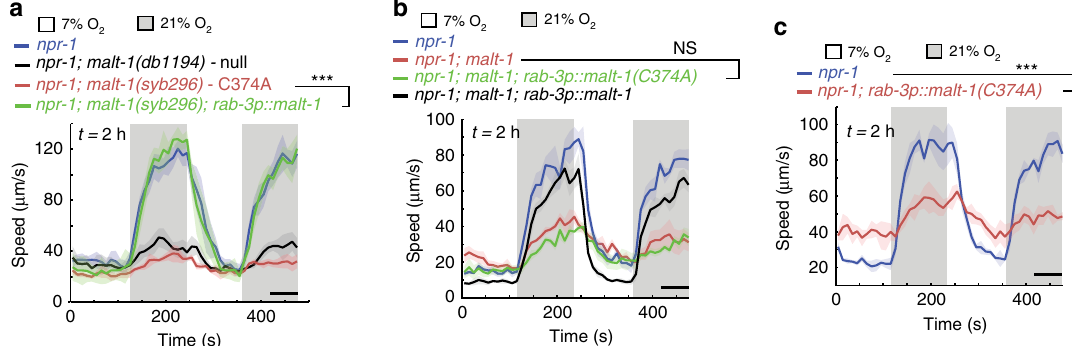
Fig. 5 MALT-1 has enzymatic roles in IL-17 signaling. a – c MALT-1 ’ s function in the nervous system requires its protease active site. a malt-1(syb296) mutants that express a catalytically inactive MALT-1 (C374A) show O 2 response defects comparable to those of malt-1(null) animals. Pan-neuronal expression of malt-1 cDNA rescues this phenotype. n = 53 animals ( npr-1 ), n = 55 animals ( npr-1; malt-1(db1194) ), n = 50 animals ( npr-1; malt-1(syb296) ), n = 29 animals ( npr-1; malt-1(syb296); rab-3p::malt-1 ). Plots show average speed (line) and SEM (shaded regions). *** P = 2.95e − 09, two-sided Mann- Whitney U test. b cDNA encoding a MALT-1 C374A catalytically inactive protein, expressed from the rab-3 promoter, does not rescue the O 2 response defects of malt-1 mutants. Data corresponding to npr-1 and npr-1; malt-1; rab-3p::malt-1 in b are the same as those shown in Fig. 1m, and were obtained in parallel to the genotypes shown. n = 46 animals ( npr-1 ), n = 74 animals ( npr-1; malt-1 ), n = 71 animals ( npr-1; malt-1; rab-3p::malt-1(C374A) ), n = 46 animals ( npr-1; malt-1; rab-3p::malt-1 ). Plots show average speed (line) and SEM (shaded regions). NS, P = 0.693918, two-sided Mann-Whitney U test. c Overexpressing MALT-1 C374A cDNA in npr-1 animals inhibits the arousal response to 21% O 2 . n = 53 animals ( npr-1 ), n = 87 animals ( npr-1; rab-3p::malt-1 (C374A ). Plots show average speed (line) and SEM (shaded regions). *** P = 1.09e − 12, two-sided Mann-Whitney U test. See also Supplementary Fig.